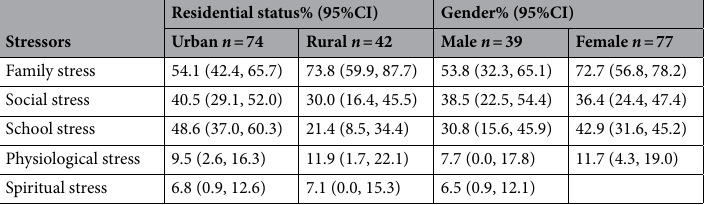
Table 3. Frequency of stressors by residential status and gender. n , number; CI, confidence